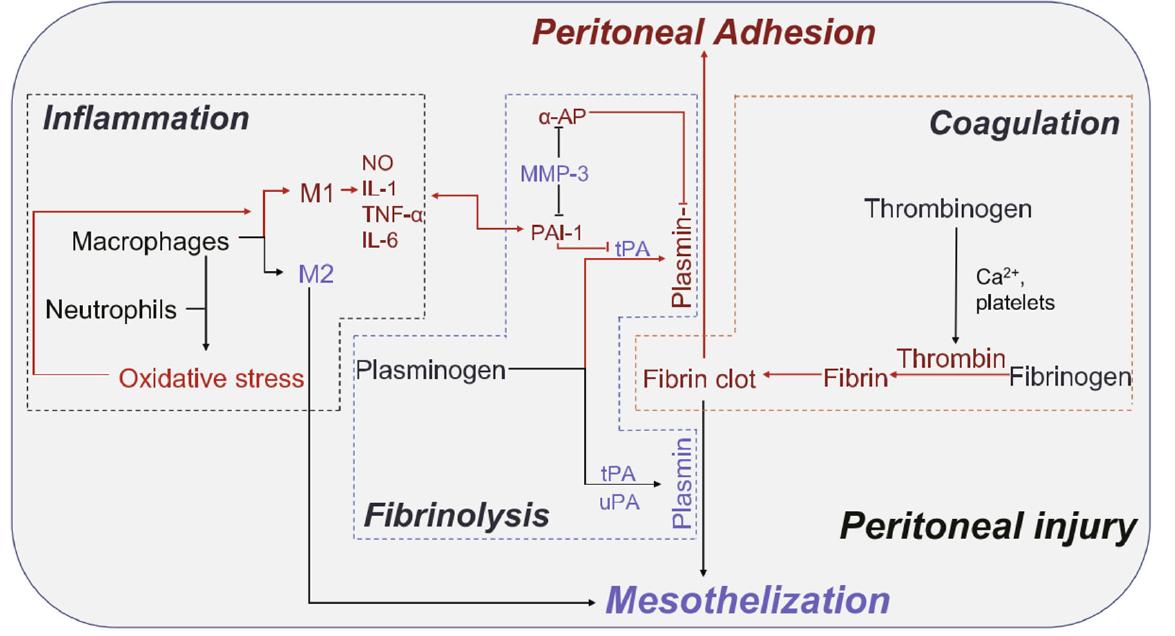
Figure 20. Schematic diagram of the interactions among coagulation, inflammation, and fibrinolysis system. Reproduced with permission from [170]. Copyright 2020 Acta Materialia Inc. Published by Elsevier Ltd. All rights reserved.